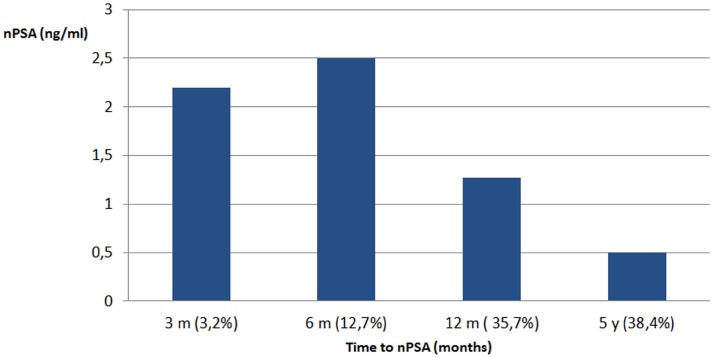
Mean nPSA values in different patients measured at specific time interval. Reaching the PSA nadir fast does not necessarily mean that the treatment is more efficient. Patients with a slowly declining PSA tended to reach a lower PSA nadir.